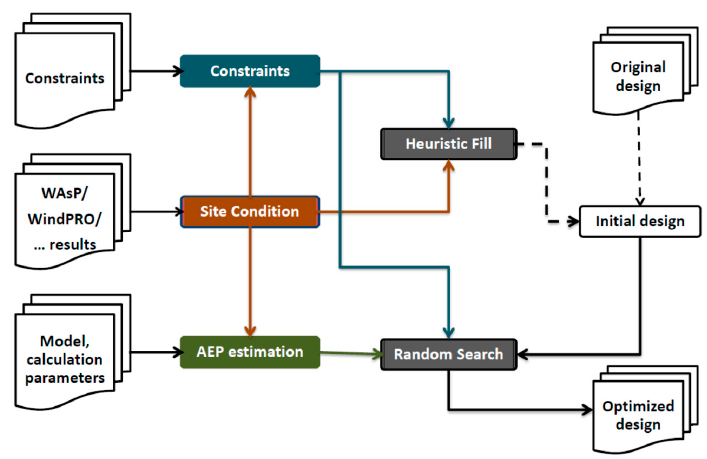
Figure 5. Architecture of the framework.